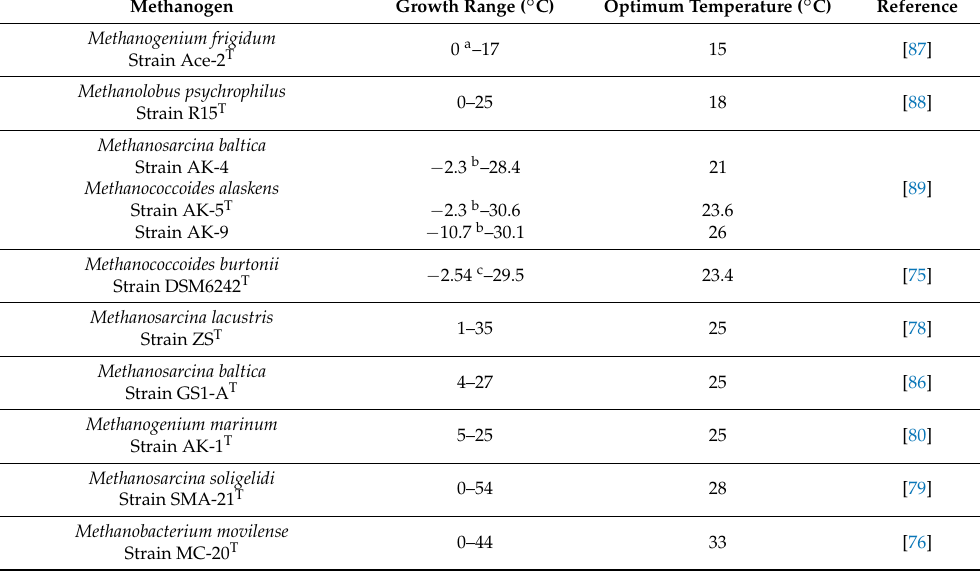
Table 6. Methanogenic archaea isolated from permanently cold